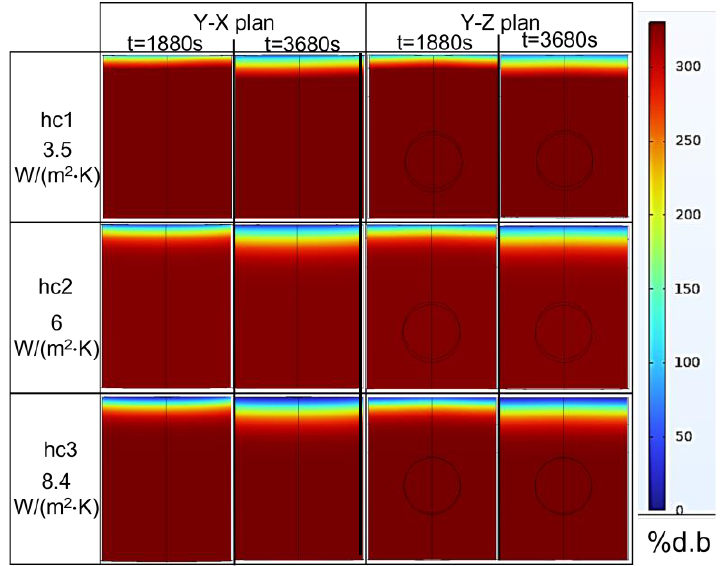
Figure 16. Two-dimensional plan of water concentration levels (% d.b.) at t = 1880 s and t = 3680 s for various heat-transfer coefficients on the surface of the pâté sample.